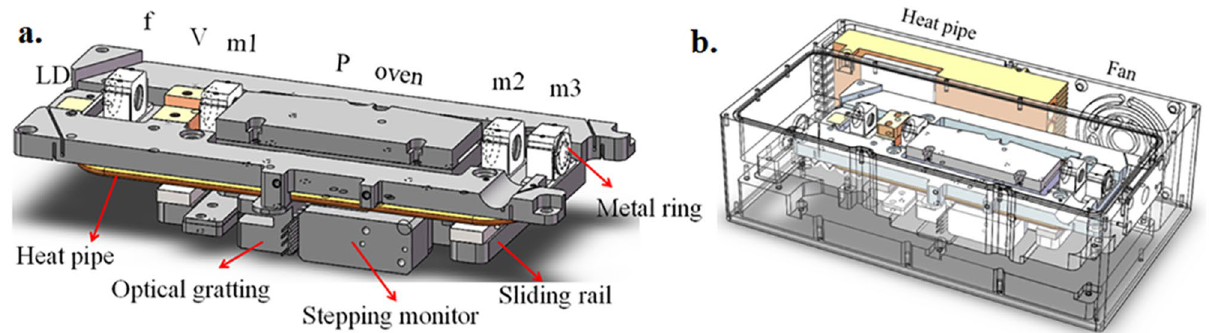
Figure 7. Design of the singly resonant IC-OPO prototype. LD: solid 808 nm laser diode; f: focusing lens; V: Nd:YVO 4 crystal; m1: IC-OPO input mirror; P: PPLN crystal; m2: IC-OPO output mirror; m3: dichroic mirrors. (Solid Works 2018, https ://www.solid works .com/, Microsoft Office Power Point 2007, https ://www.offic e.com/, Adobe Photoshop CC 2018, https ://www.adobe .com/cn/produ cts/photo